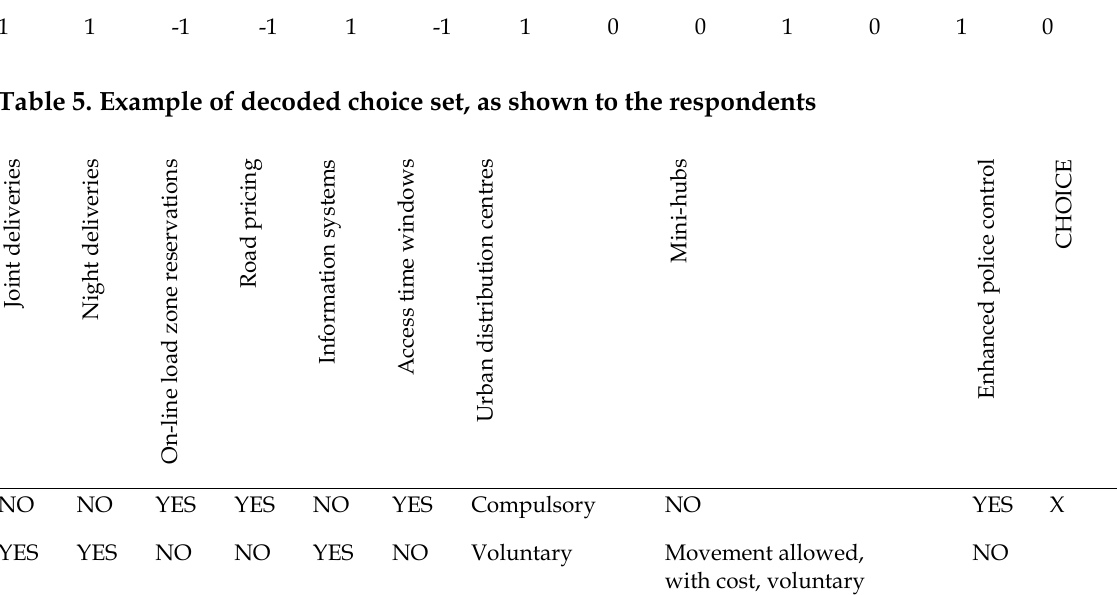
Table 6. Weights estimated by the discrete choice analysis for the different urban logistics solutions in